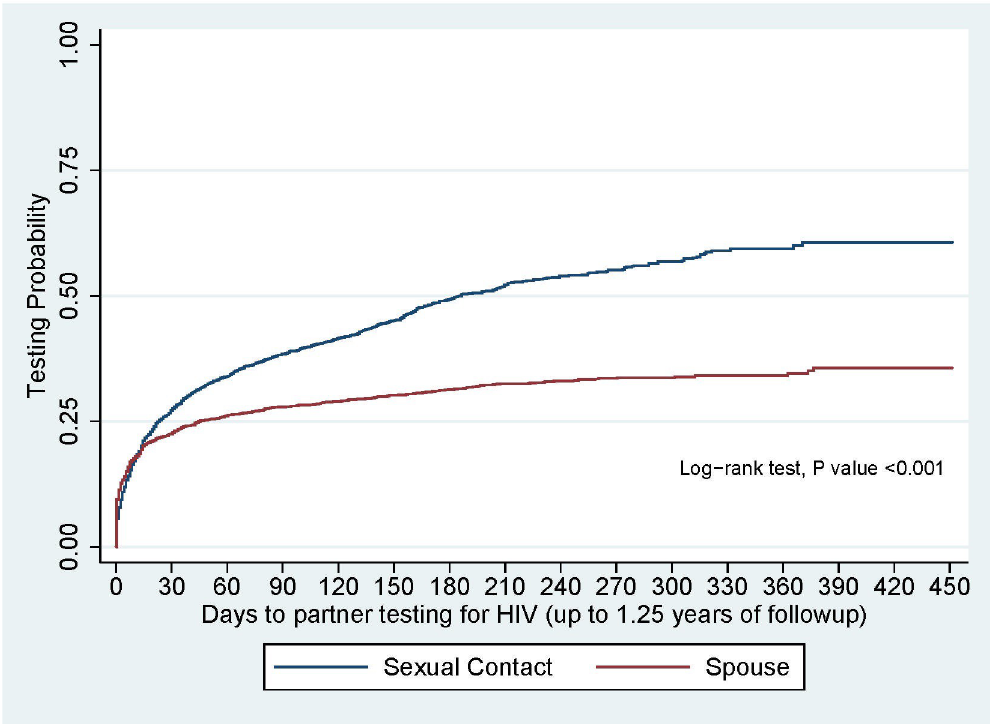
Fig 2. Contact time to test for HIV by relationship to